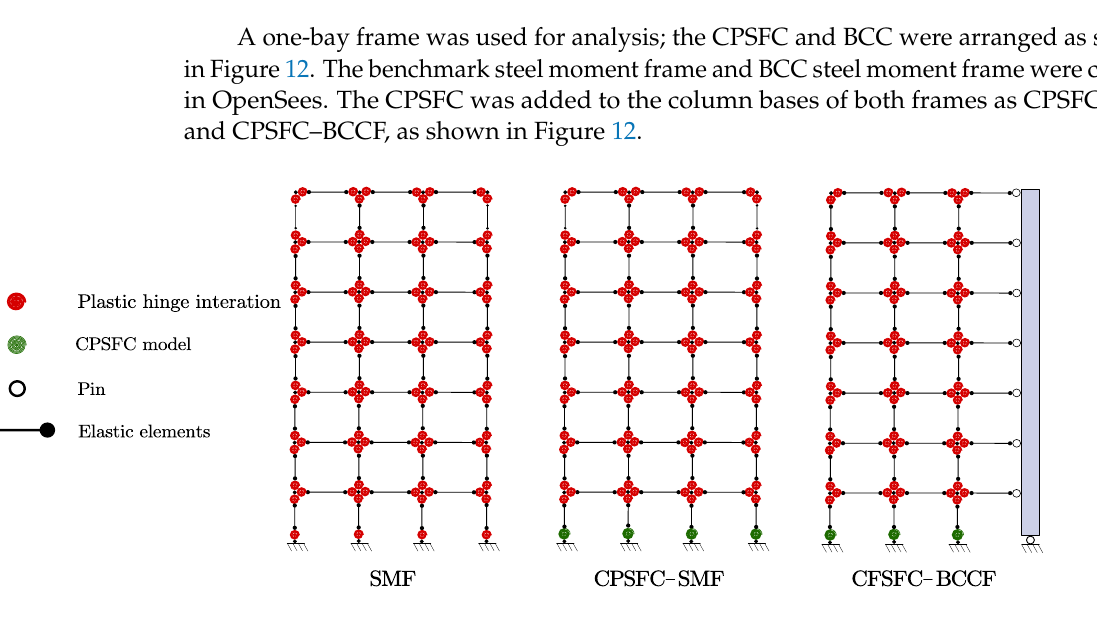
Figure 12. Schematic illustration of finite element models.